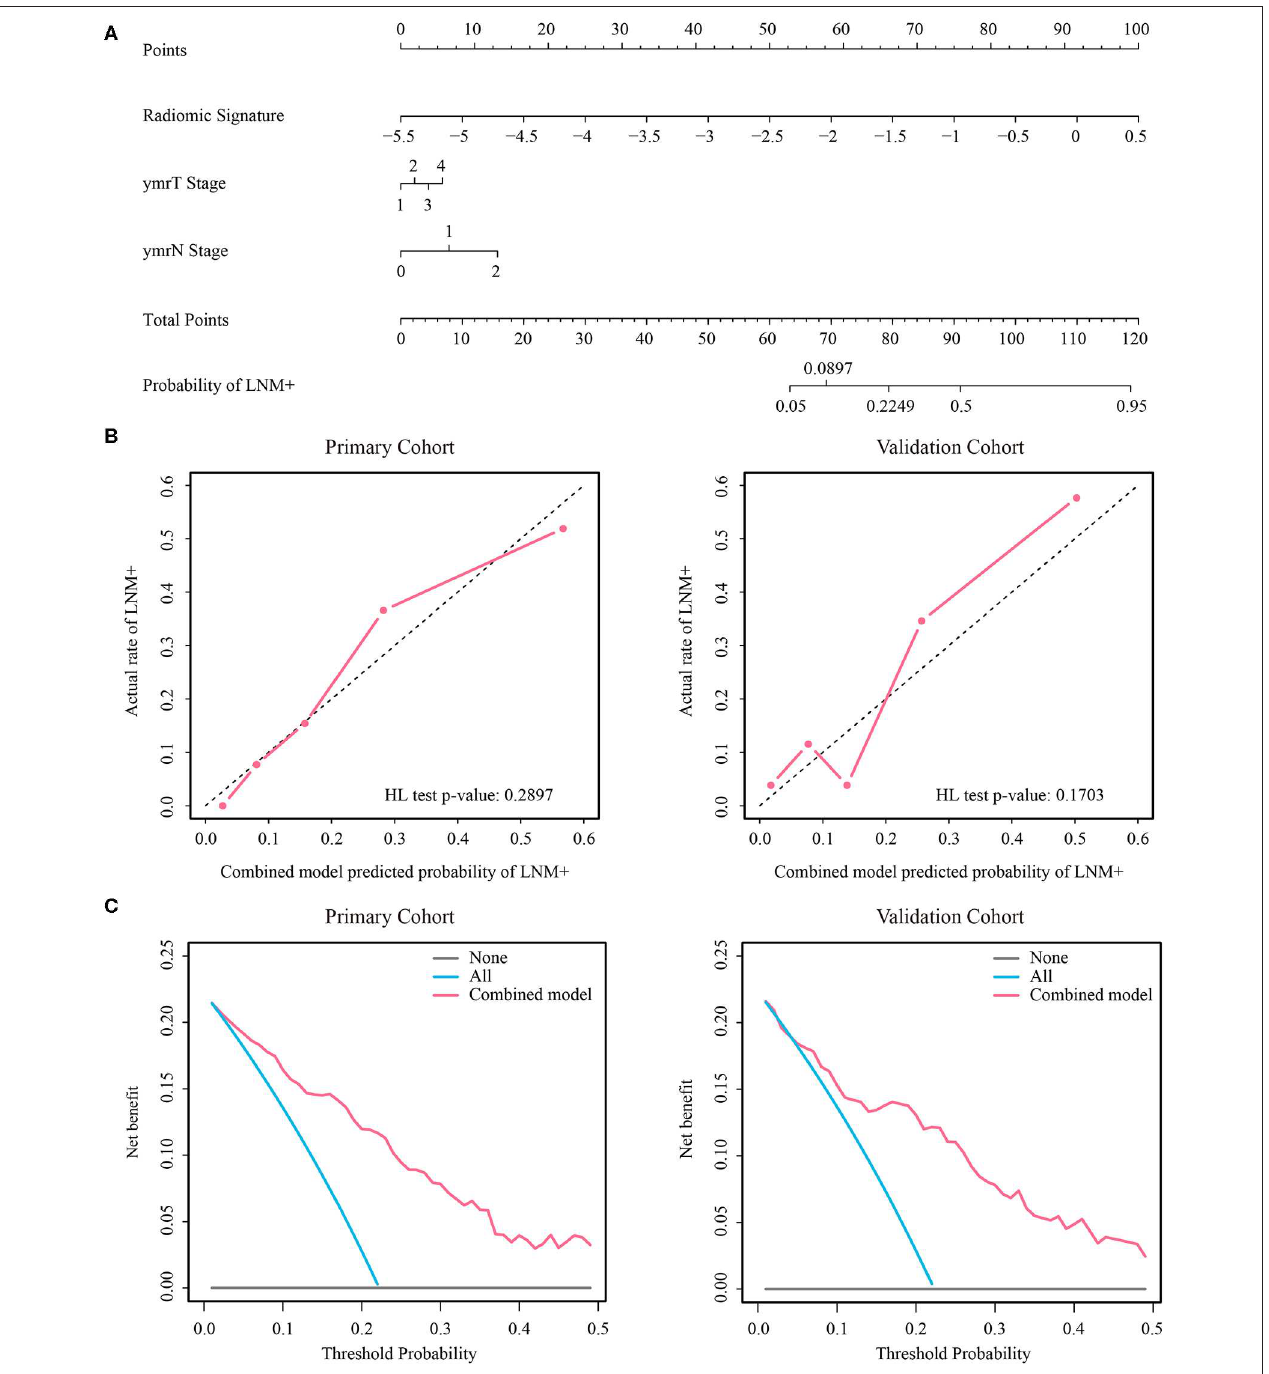
FIGURE 4 | (A) Nomogram of the combined model. (B) Calibration curves of the combined model in both cohorts. (C) Decision curve analysis of the combined model in both cohorts. LNM + , lymph node metastasis; HL, Hosmer-Lemeshow.